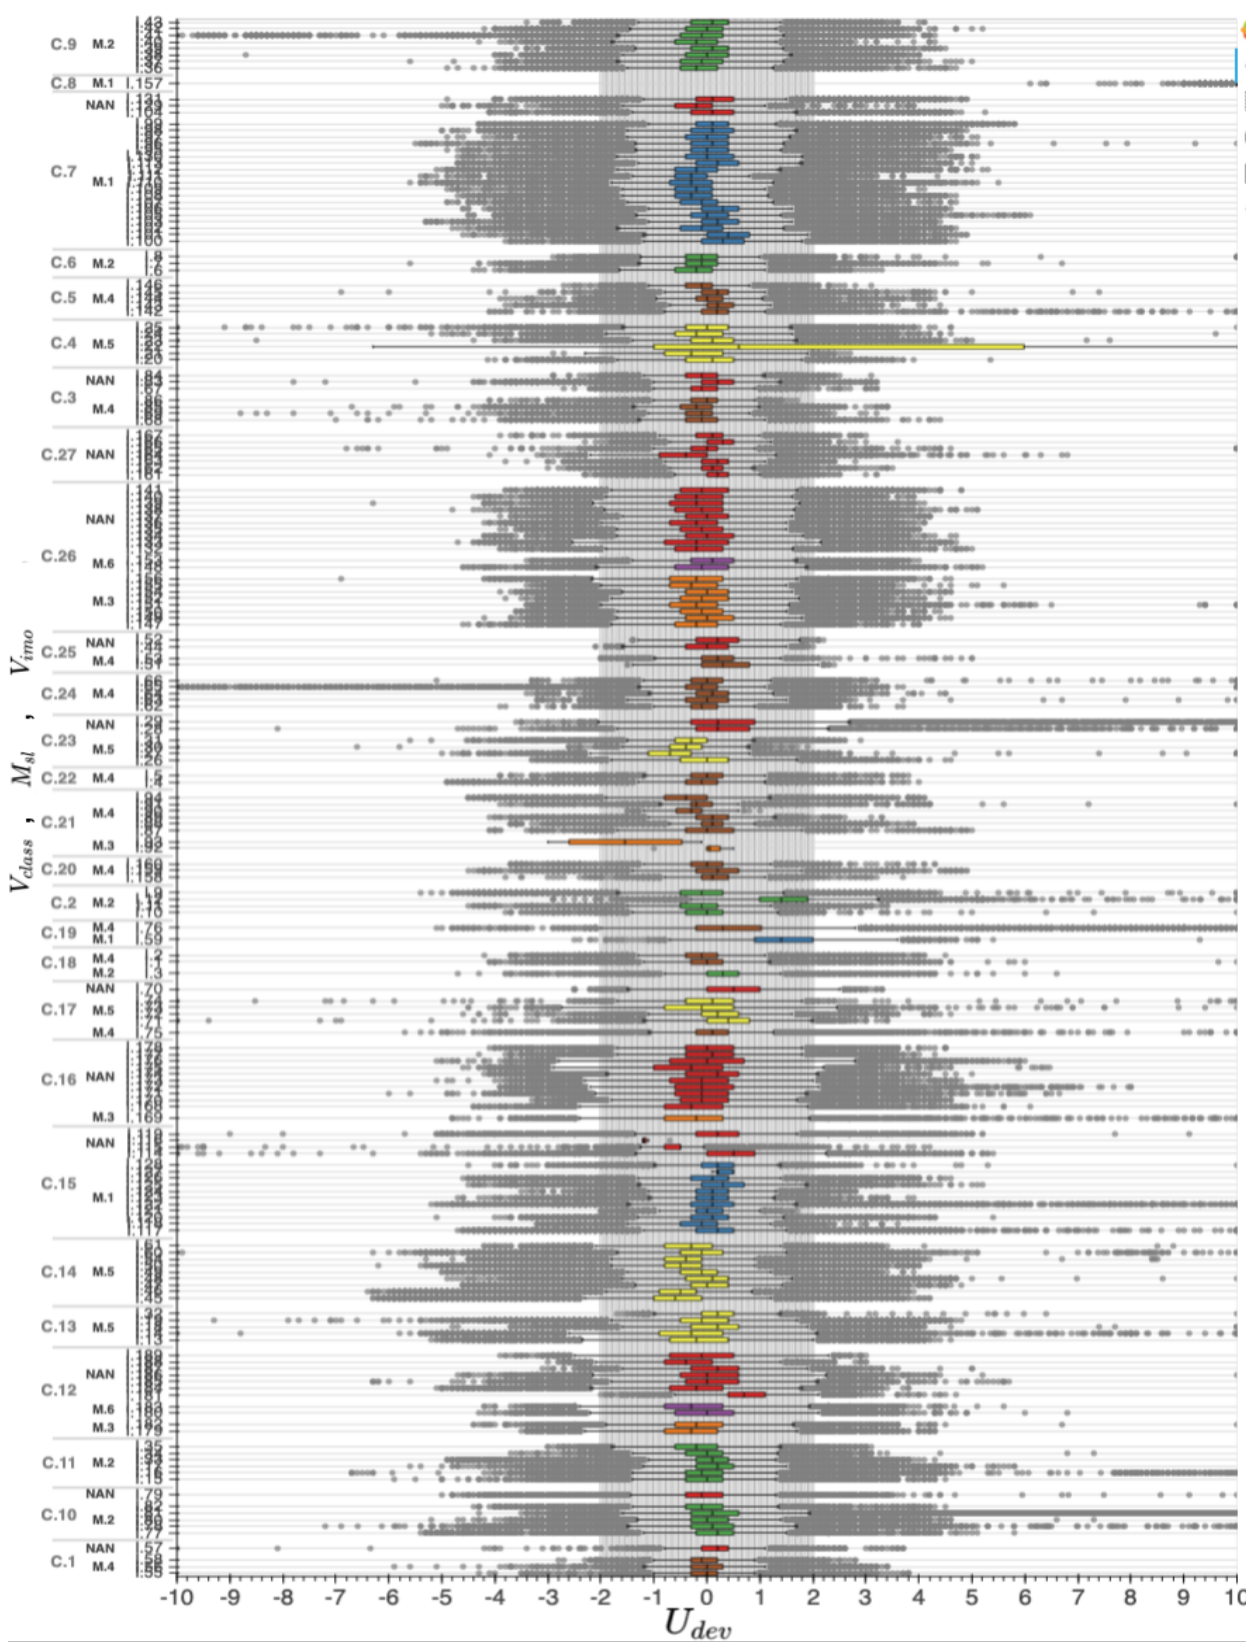
Figure 9. Boxplot of U dev by vessel class V class , DVL manufacturer M sl and imoNo V imo